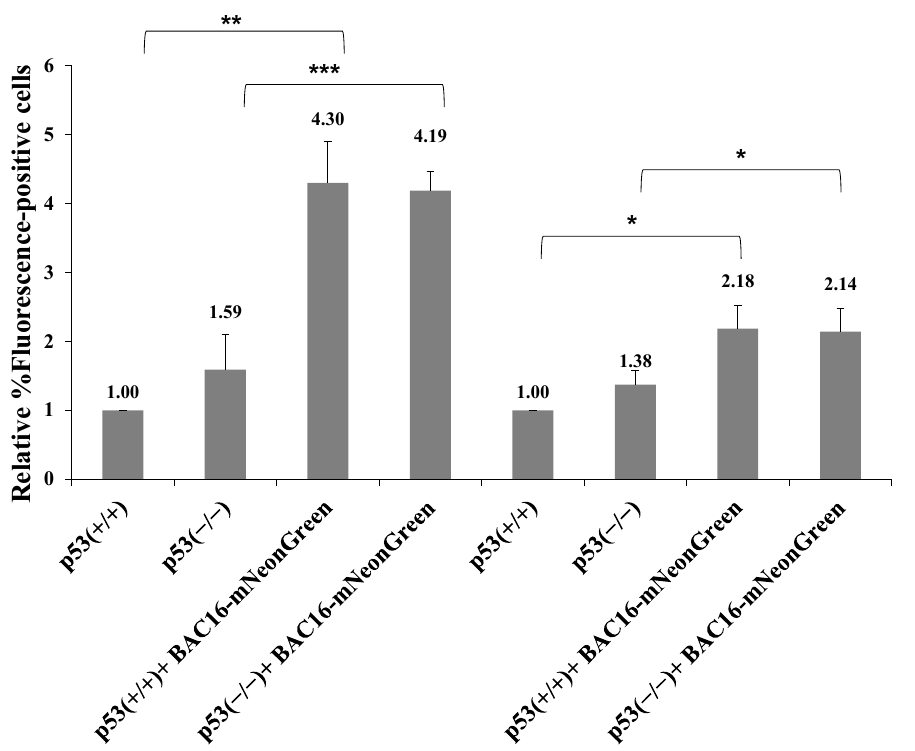
Figure 13. p53 protein is not involved in regulating the establishment of latent KSHV infection during superinfection. Naive HCT-116 cells expressing wild-type p53 protein (p53+/+) and an isogenic line lacking full-length p53 expression (p53 − / − ) as well as the corresponding BAC16-mNeonGreen- infected cells were seeded in 12-well plates (140,000 cells per well). The next day, the cells were infected with BAC16-mCherry virus at an MOI of 0.1 and 0.25 using the spinoculation method. After 48 hr, the cells were harvested, and the percentage of cells expressing mCherry was measured by FACS. Percentages obtained in HCT-p53+/+ cells were normalized to 1 and all the samples were compared to these baselines. Results shown are based on three experiments. Statistical analysis was performed using the Two-way ANOVA + Tukey’s post hoc analysis. * p < 0.05, ** p < 0.01, *** p < 0.001.